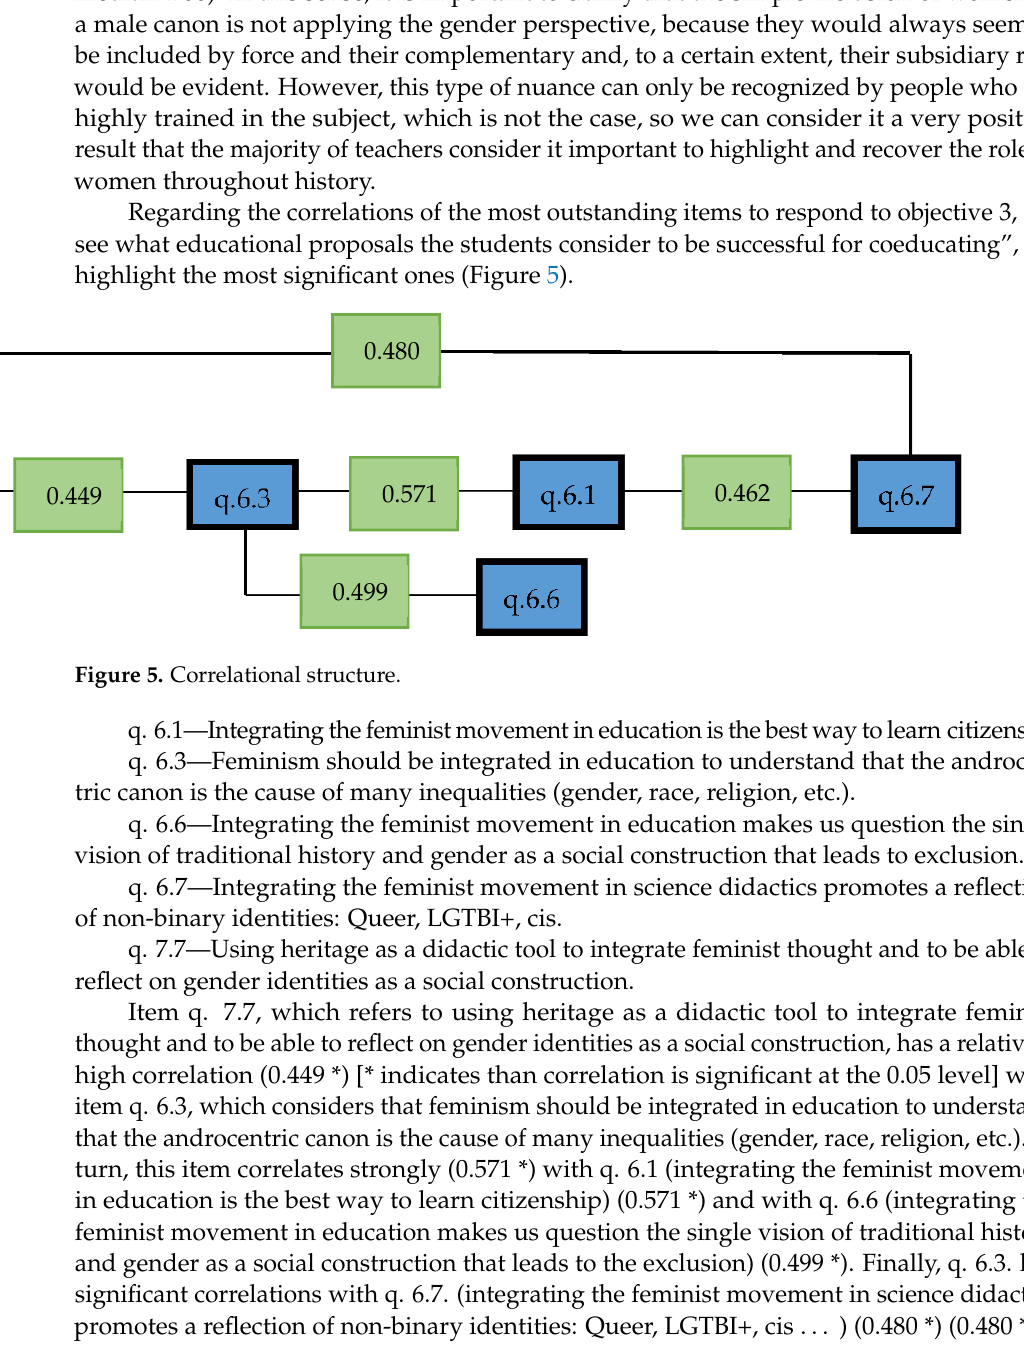
Table 7. Measures of key trends (mode, median and arithmetical average) for question 6.